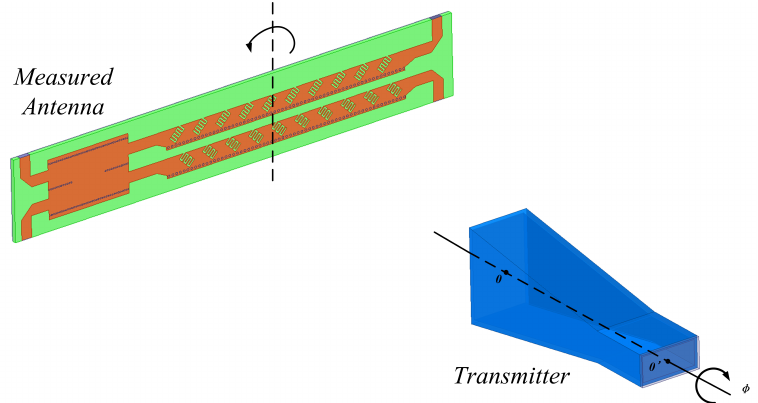
Figure 16. Measurement setup used to test the proposed antenna. The measured gains of RHCP or LHCP are plotted in Figure 17a,b when Port 1 or 2 is excited. Table 1 summarizes the key measurement and simulation data of RHCP and LHCP. The proposed antenna can cover the angle range of ( − 38.5 ◦ , − 10 ◦ ) for RHCP and ( − 40.5 ◦ , − 11.5 ◦ ) for LHCP with the 3 dB beam-width in the x–z plane. The axial ratio of the beam directions is always below 2